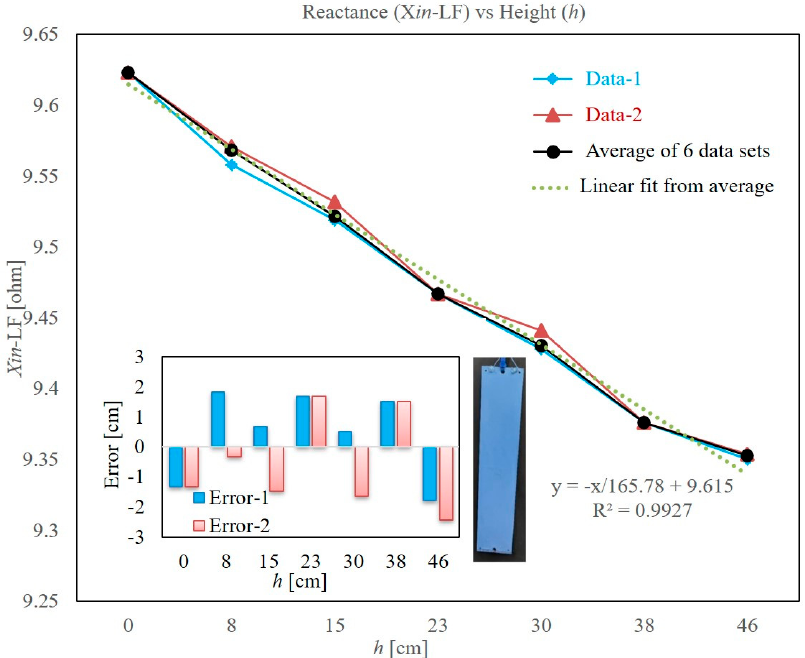
Figure 6. Results of repeatability test. The hydrophobic painted PCB used is shown in the inset photograph. Error in the estimated level with respect to the linear-fit equation is shown in the inset graph. Error-1 and error-2 represent two sets of data where the maximum and second maximum deviations are noted, respectively.